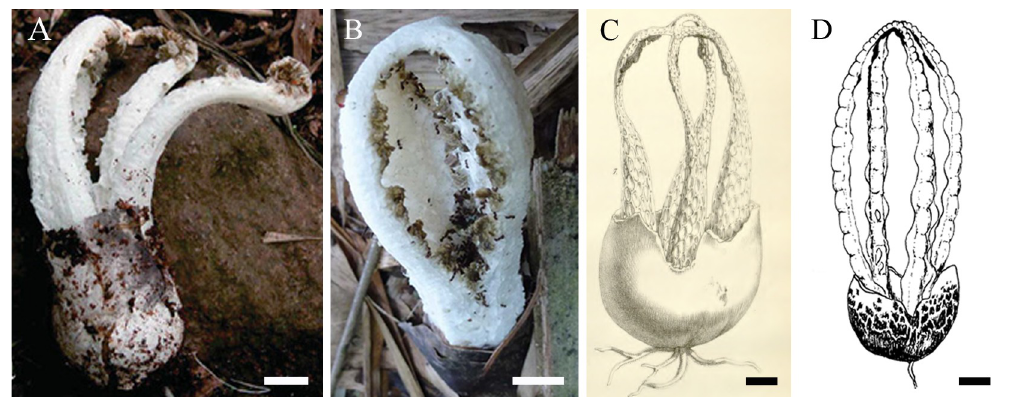
Fig 4. Blumenavia angolensis . (A) Fresh basidiomata from S ã o Tome´, reproduced from Degreef et al. [8] Fig 2C, © Publications Scientifiques du Muséum national d’Histoire naturelle , Paris. (B) Fresh basidiomata from S ã o Tome´, reproduced from Desjardin and Perry [11] Fig 6, © Desjardin and Perry. (C) Basionym Laternea angolensis , reproduced from Welwitsch and Currey [5] Tab. 17, Fig 7. (D) Illustration reproduced from Dring [4] Fig 15F, © Board of Trustees of the Royal Botanic Gardens , Kew . (A–D) bar = 10